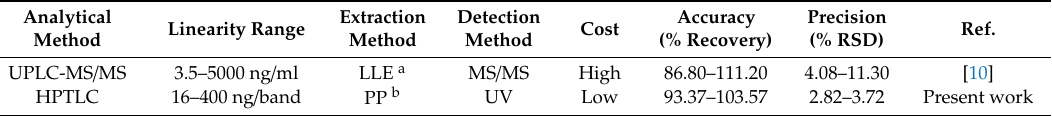
Table 7. Comparison of the proposed HPTLC method with reported UPLC-MS / MS method for the determination of DLX in